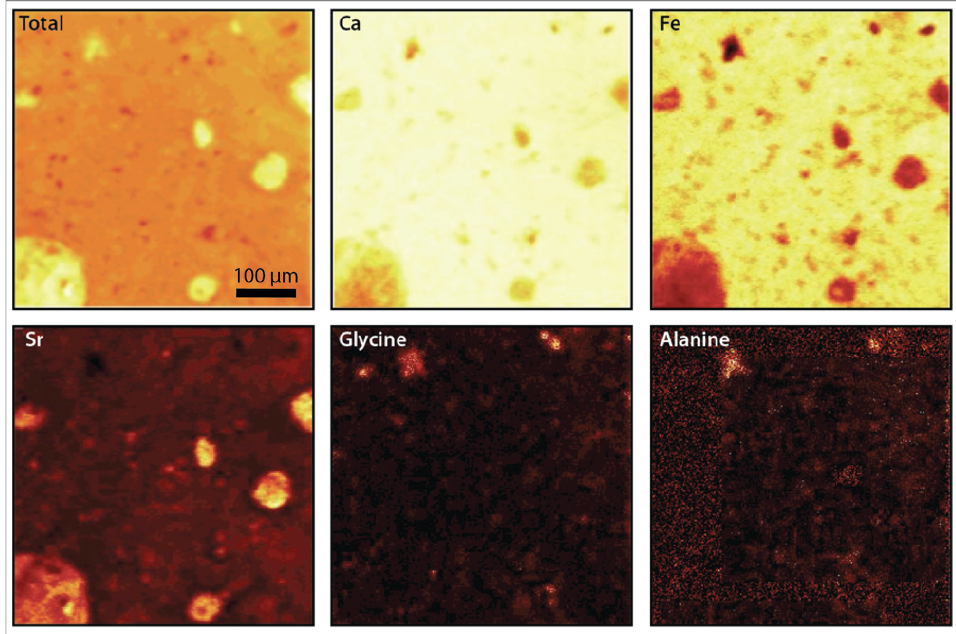
Figure 2. TOF-SIMS images of HQ bone fragment (GR1066). Each image is the same 500 × 500 µm area of the bone. The lighter areas represent a greater concentration of a given element or molecule, while the darker areas represent a lower concentration. The total map shows all 86 peaks in the analysis, showing a higher concentration in pore spaces. The rest of the maps show the distribution of specific elements and molecules. Specific features of the bone, like pore spaces, have a higher concentration of strontium (Sr) and lower concentrations of iron (Fe) while some elements, like calcium (Ca) are ubiquitous across the sample surface. Amino acids like glycine and alanine are both present in a single area of the bone.